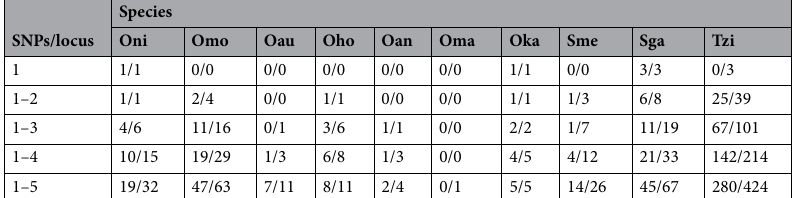
Table 2. Number of species-specific SNPs identified in loci with up to five species-specific SNPs per locus. Numbers shown are for DBA/RBA respectively (see text for further